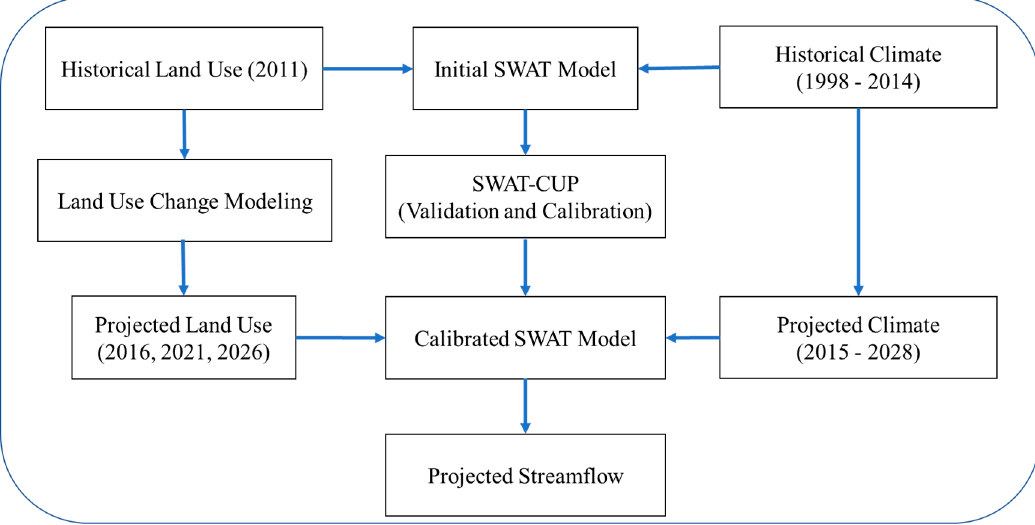
Figure 2. Conceptual modeling framework used for the modeling impact of changing land use and climate on the streamflow in the selected study area. SWAT-CUP—Soil and Water Assessment Tool-Calibration and Uncertainty Program.